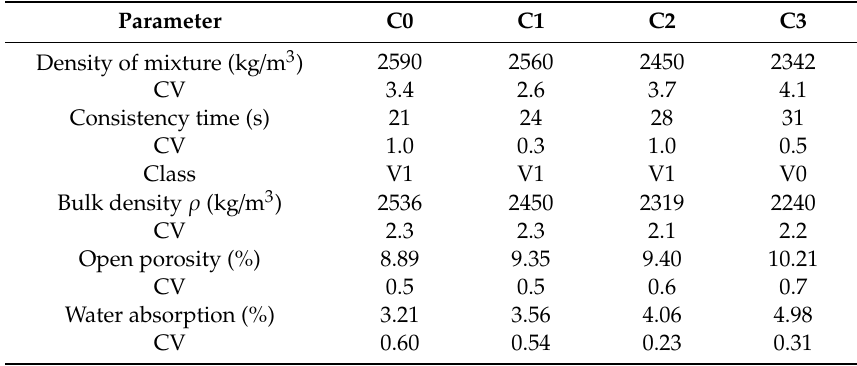
Table 4. Physical properties of the concretes.